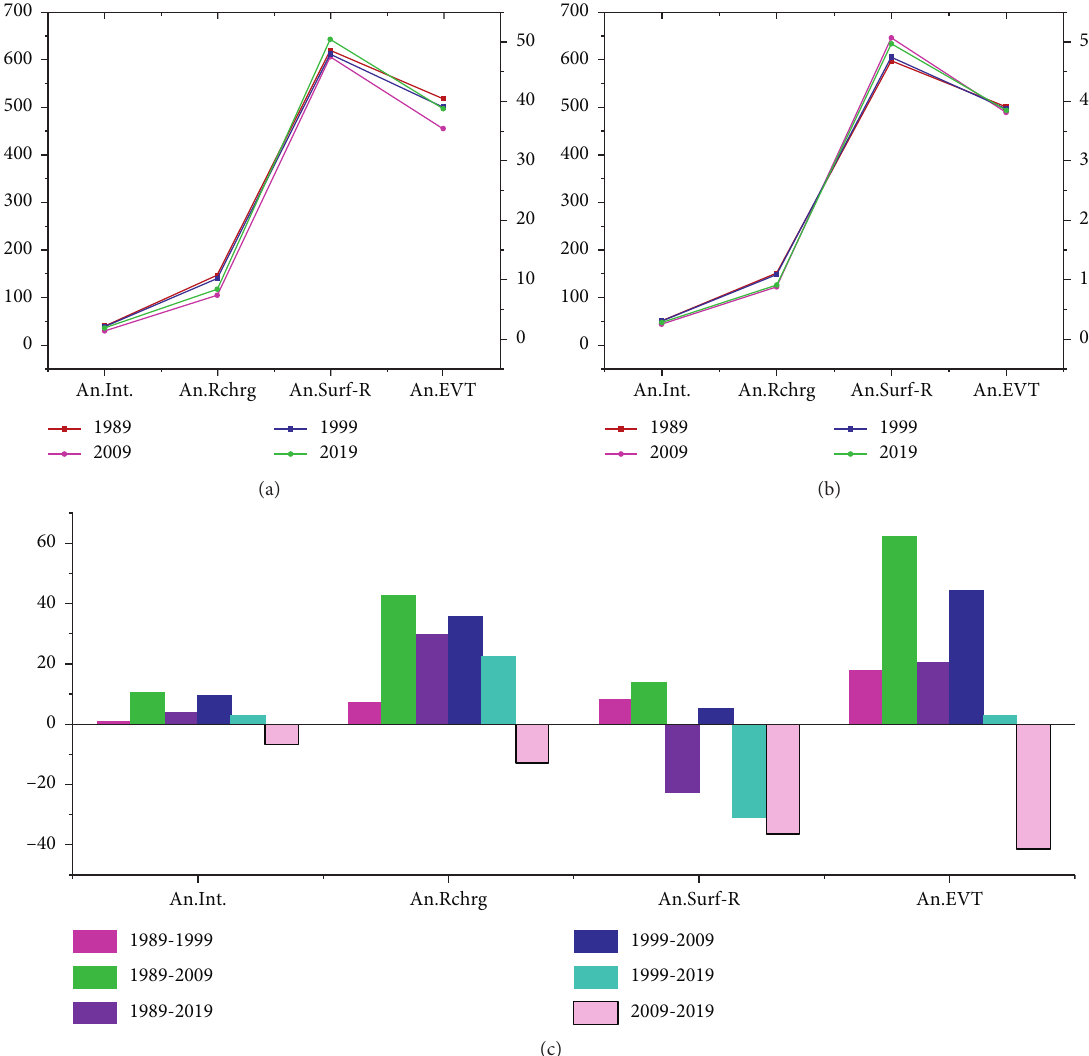
Figure 13: Mean annual water balance component. (a) Mean annual water balance component in (mm), (b) mean annual water balance component in (%), and (c) mean annual water balance component changes (mm)) where An. Int � mean annual Interception, An. Rchrg � mean annual recharge, An. Surf-R � mean annual surface runoff, and An. EVT � mean annual